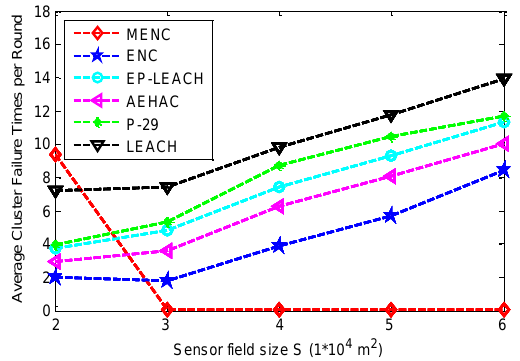
Figure 9. The comparison of ACFTR among MENC, ENC, EP-LEACH, AEHAC, P-29 and LEACH for different sensor field sizes.